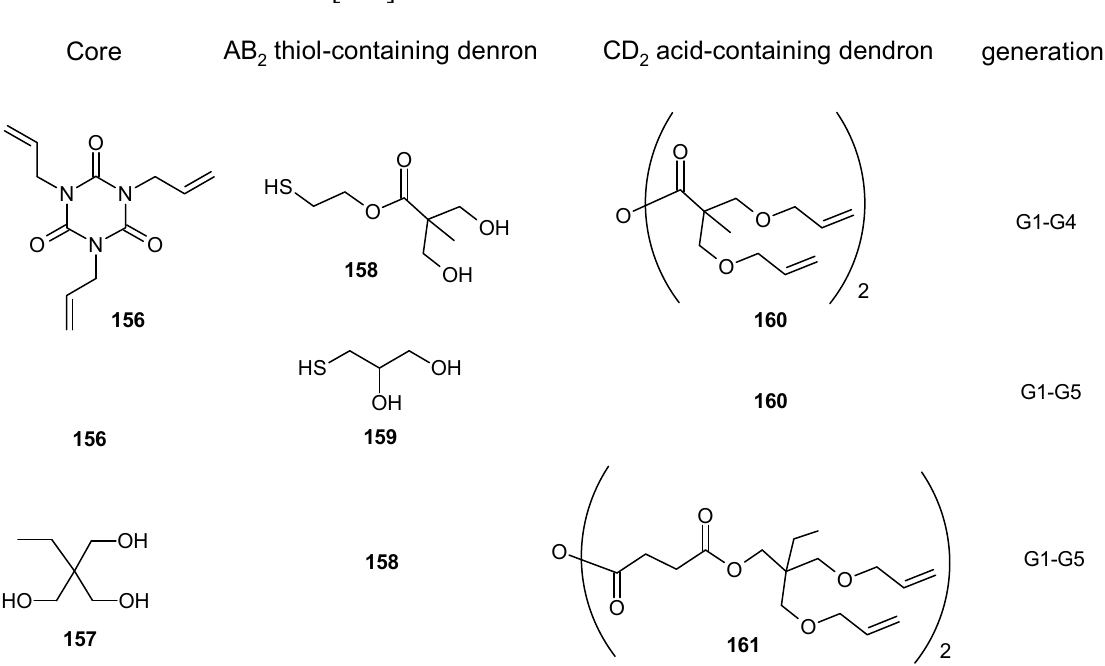
Figure 11. Monomers and cores employed for the synthesis of dendrimers using thiol-ene and esterification reactions